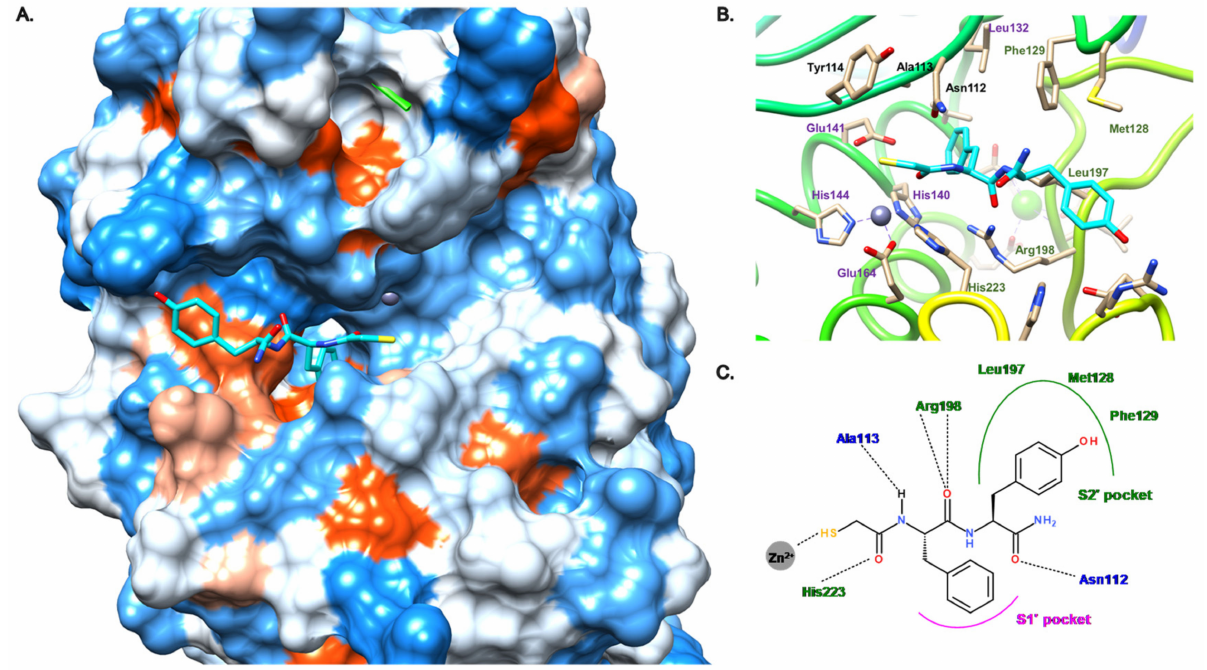
Figure 5. Docking simulation of compound 8 from PDB entry 3DBK using Chimera 1.15. ( A ) View of the active site of LasB, in surface mode, accommodating 8 (green) visualized using Chimera 1.15. The zinc cation is represented as a gray sphere. ( B ) View of the active site of LasB with 8 (blue) and key residues (gray sticks) involved in the binding visualized using Chimera 1.15. ( C ) Two-dimensional schematic representation of the hypothetic binding mode. The key interactions are indicated as dashes, the zinc cation is represented as a gray sphere, and the key residues are indicated in pink for those belonging to the S1 (cid:48) pocket, green for those belonging to the S2 (cid:48) pocket and blue for the others. A tripeptide HS-CH 2 -( DL )Leu-Phe-Ala-NH 2 , known as a potent inhibitor of